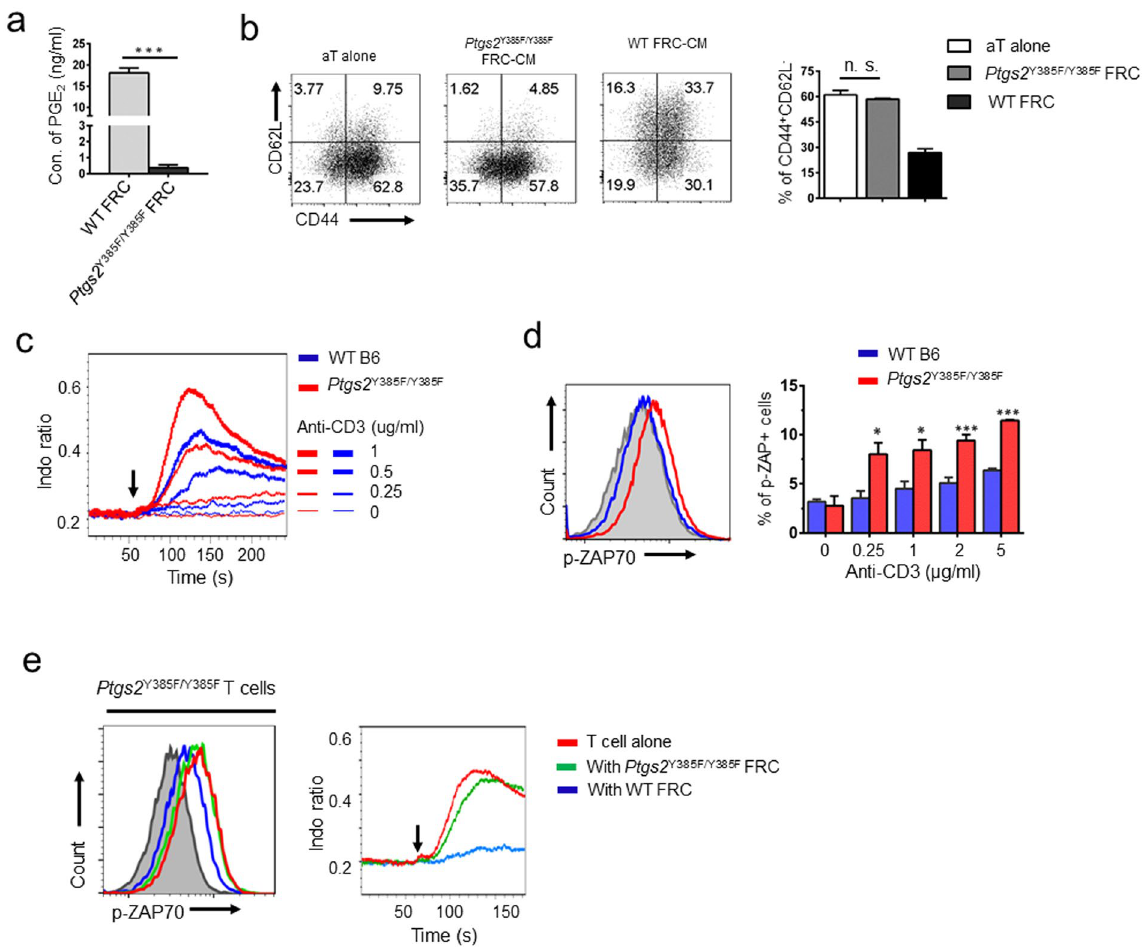
Figure 5. Hyperactive COX-2/PGE 2 pathway in SLN-FRCs is associated with suppressed TCR-signaling cascade upon activation, which is reversible by genetic inactivation of Cox-2 . ( a ) PGE 2 concentration in the supernatant of WT and Ptgs2 Y385F/Y385F FRCs following 24 hrs culture was examined. ( b ) FRC-CM of C57BL/6 and Ptgs2 Y385F/Y385F mice was added to T cell activation culture at a dilution of 1:1. The effects on T cell activation were examined via changes in CD44 and CD62L expression. ( c ) Freshly isolated T cells from C57BL/6 WT or Ptgs2 Y385F/Y385F mice were used to determine their response to various level of anti-CD3 (0.25–1 μ g/ml) stimulation as calcium-flux via flow cytometry. ( d ) ZAP70 phosphorylation in freshly isolated T cells of C57BL/6 WT and Ptgs2 Y385F/Y385F mice following anti-CD3 (0.25–5 μ g/ml) stimulation was examined via flow cytometry. Representative histogram of ZAP70 phosphorylation upon 2 μ g/ml anti-CD3 stimulation is shown, where unstimulated T cells (gray) was used as a negative control. ( e ) CD4 + T cells from Ptgs2 Y385F/Y385F mice were cultured overnight in the absence or presence of FRCs from C57BL/6 or Ptgs2 Y385F/Y385F mice. T cells were then stimulated with anti-CD3 (1 μ g/ml) and subjected to ZAP70 phosphorylation analysis (left) or calcium- flux assay (right). Arrow indicates the starting point of stimulation. Data ( a – e ) are representative of two to three independent experiments for CD4 + T cells (mean ± SEM; * P < 0.05, *** P < 0.001, n.s. = not significant; Nonparametric Mann-Whitney